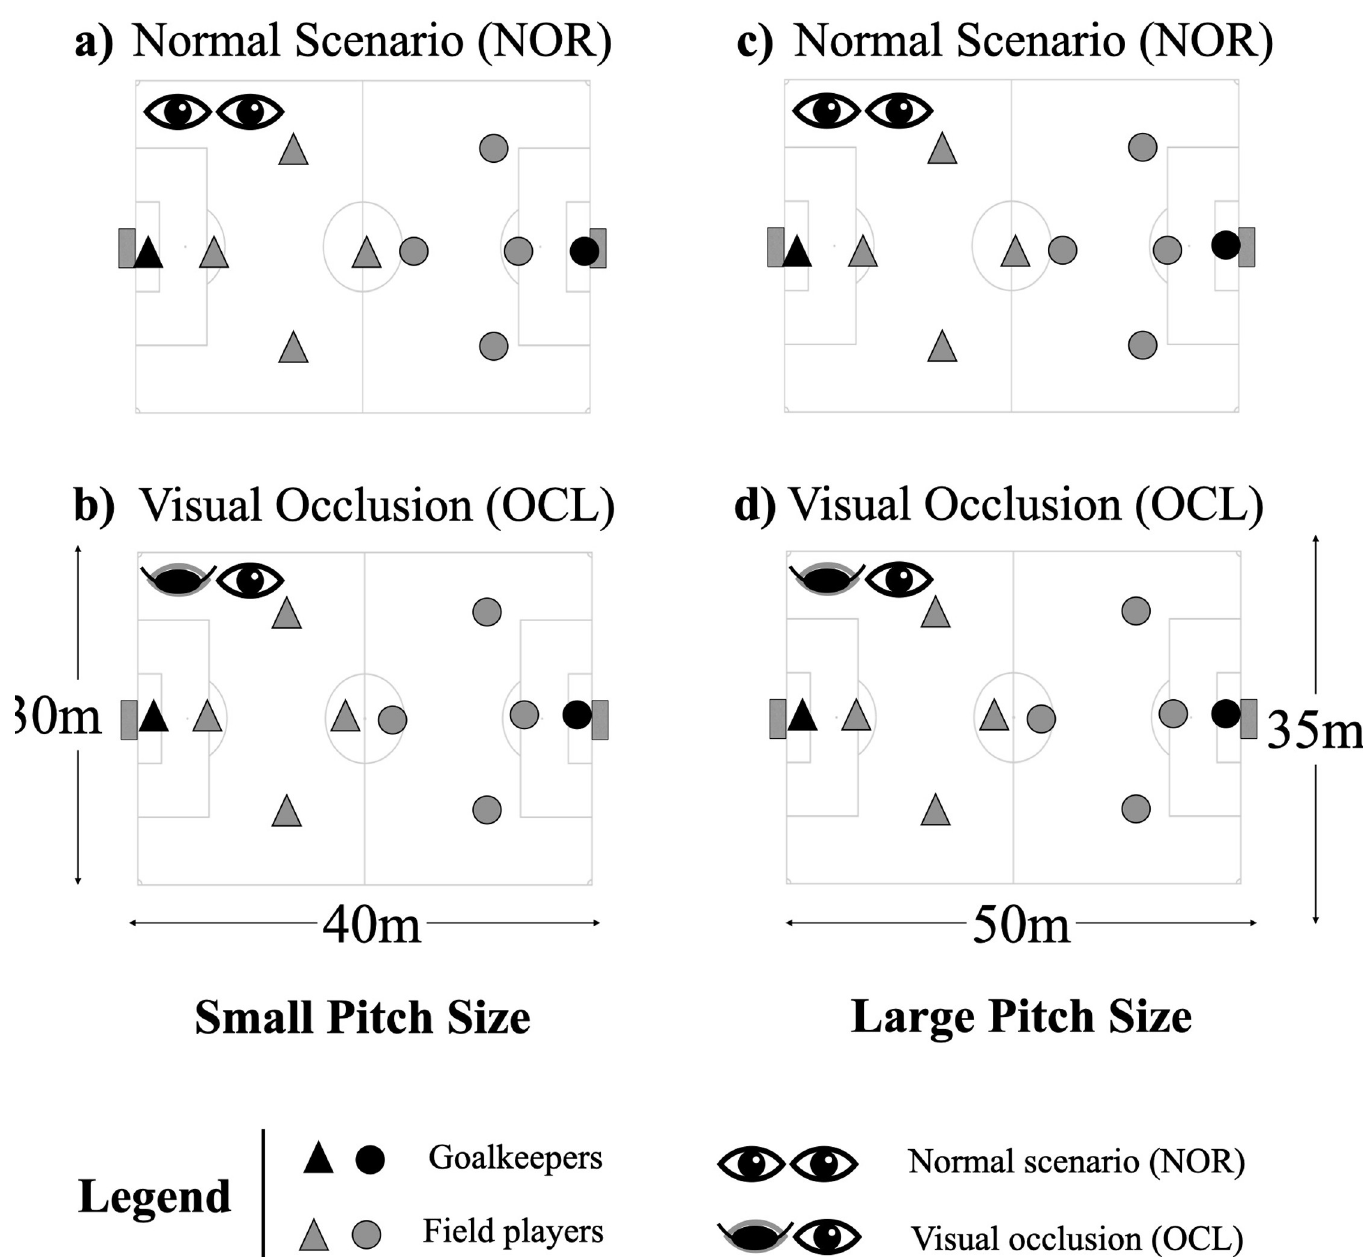
Fig 2. (a) representation of the experimental scenarios (normal—N; visual occlusion–VO); (b) schematic representation of data collection